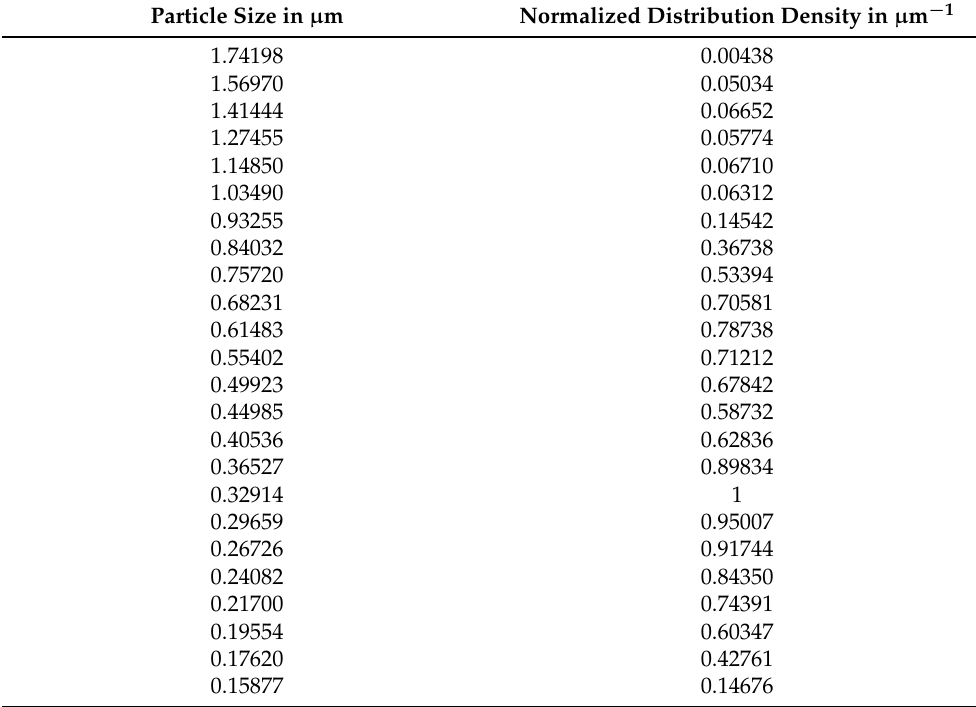
Table A13. Particle size distribution of a dispersion containing 10 m% graphite nanoparticles and 15 m%